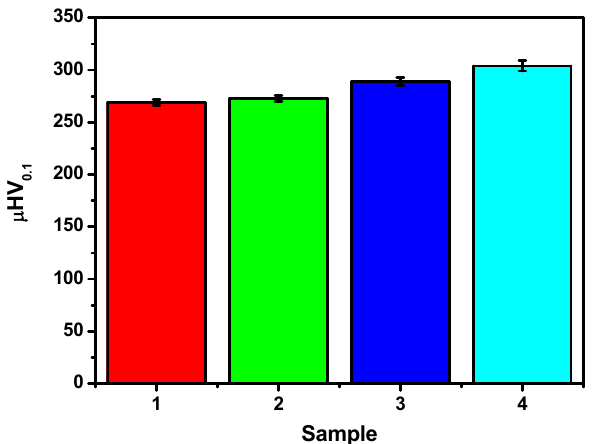
Figure 7. A Vickers microindentation on a surface of the Pd 80 Rh 20 alloy (1), α Pd 80 Rh 20 H where H / (Pd + Rh) is 0.002 (2), α - β Pd 80 Rh 20 H where H / (Pd + Rh) is 0.4 (3), and β Pd 80 Rh 20 H where H / (Pd + Rh) is 0.8 (4).